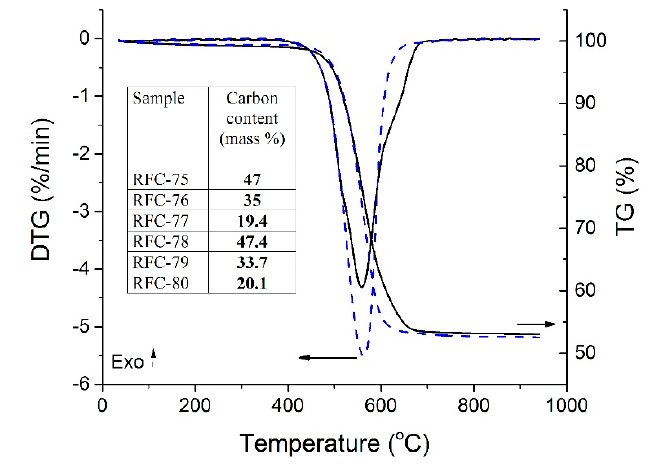
Figure 5. TG/DTG curves of the RFC-75 (straight line) and FRC-78 (dash line).